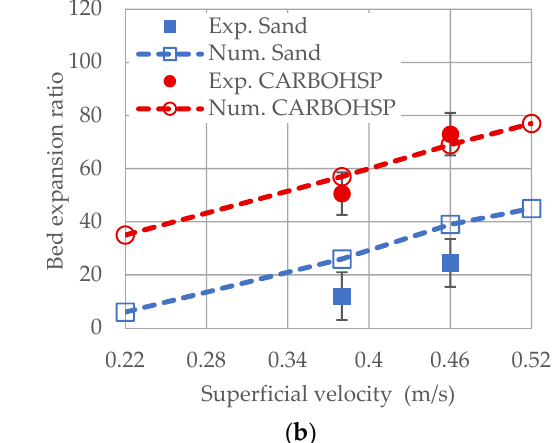
Figure 4. ( a ) Experimental and numerical results for pressure drop variation (P y = 0.025 m − P y = 0.39 m ) of the experiment with sand and CARBOHSP particles at different velocities; ( b ) the bed expansion ratio of the experiment with sand and CARBOHSP particles at different velocities, measured from both experimental and numerical studies. Error bars are provided to indicate the uncertainty in the estimations.